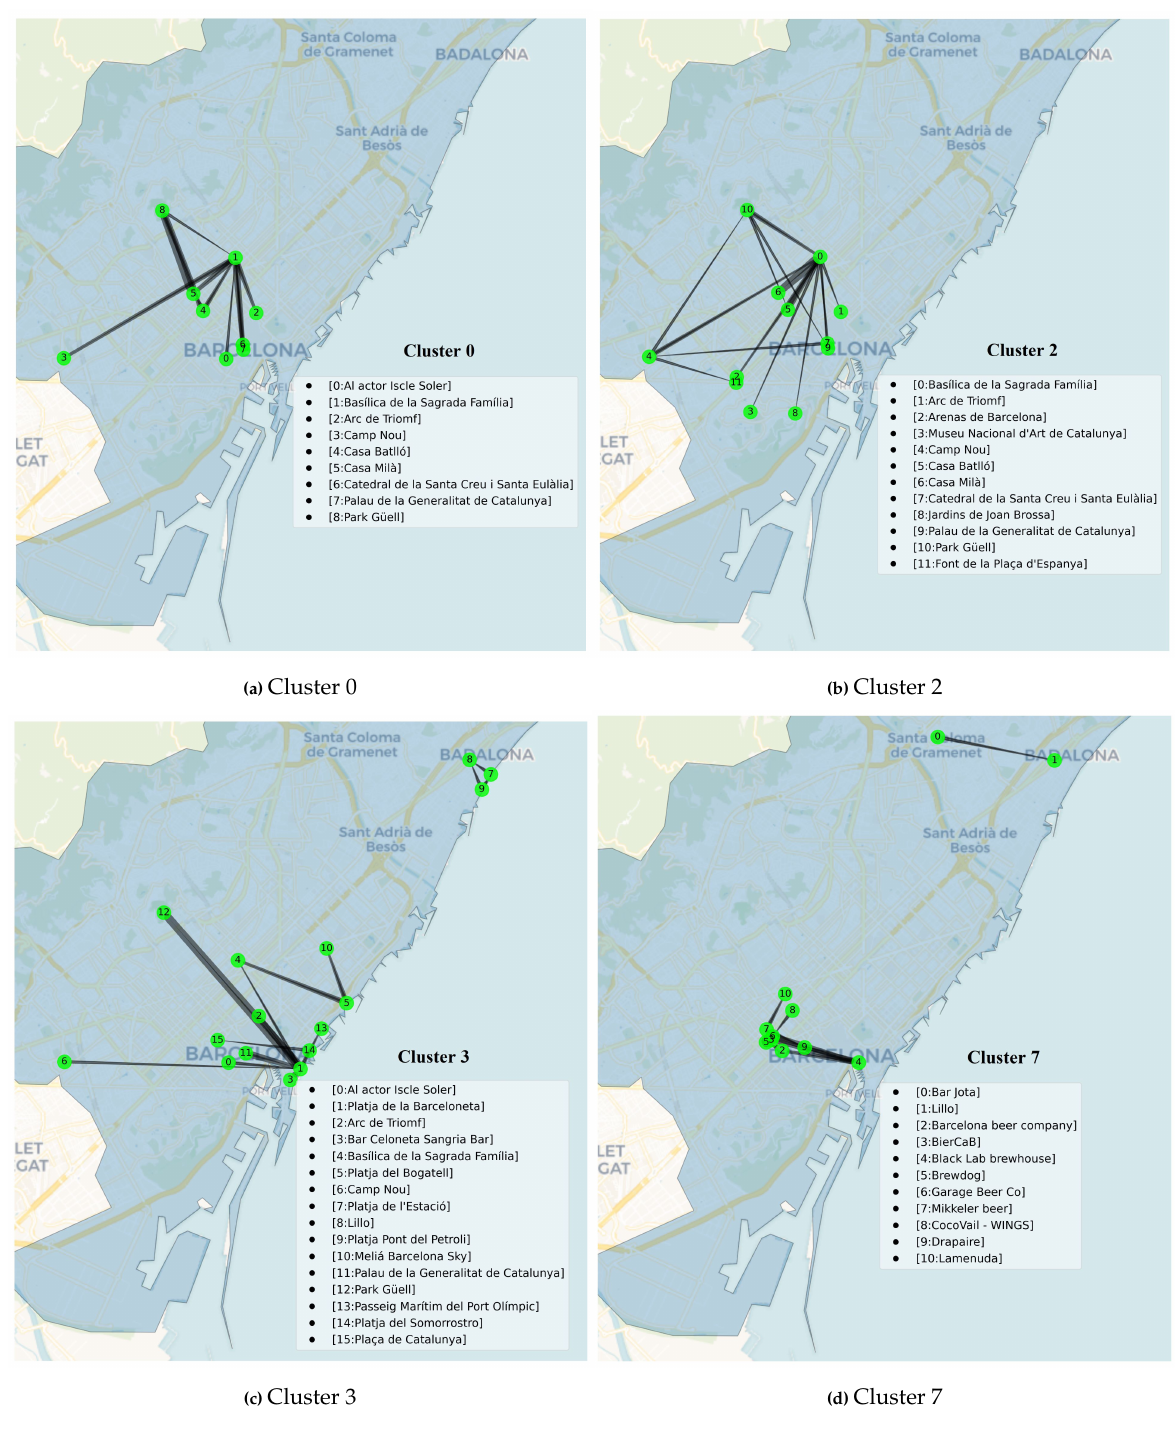
Figure 4. Tourist mobility pattern between attractions in Barcelona for clusters 0, 2, 3, and